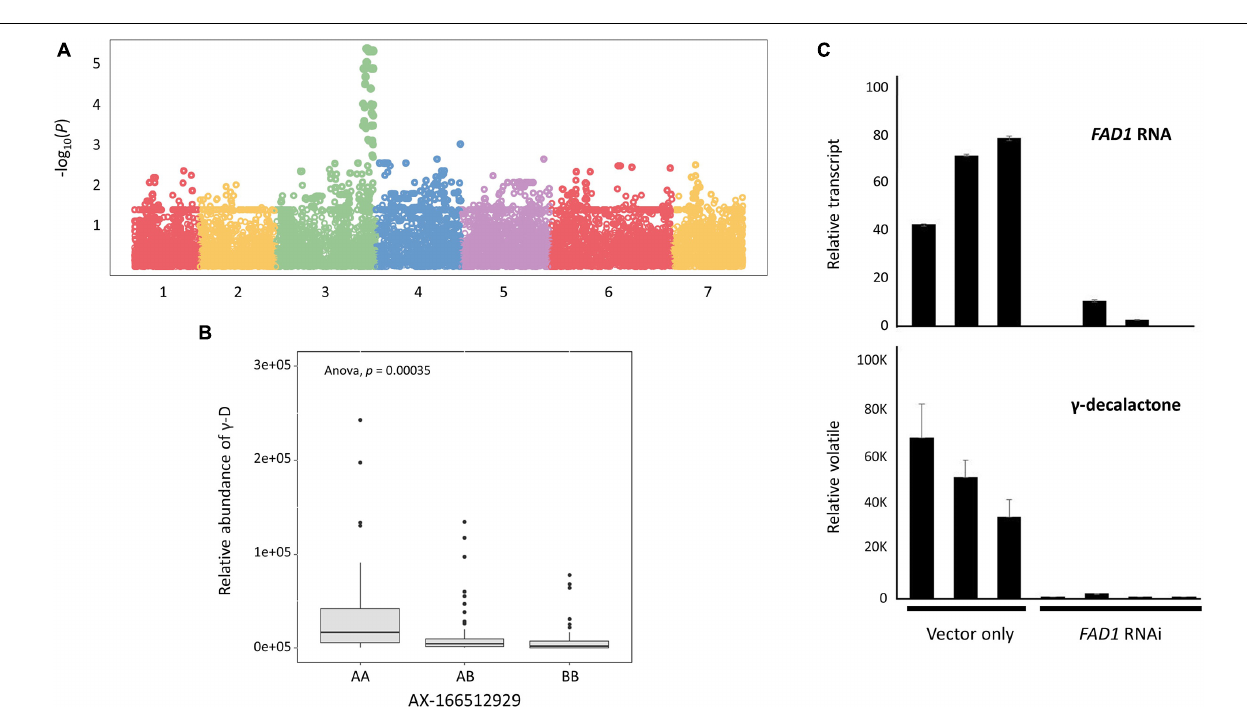
FIGURE 1 | Schematic diagram for the genomic characterization of fruity aroma gene FaFAD1 in the octoploid cultivated strawberry.